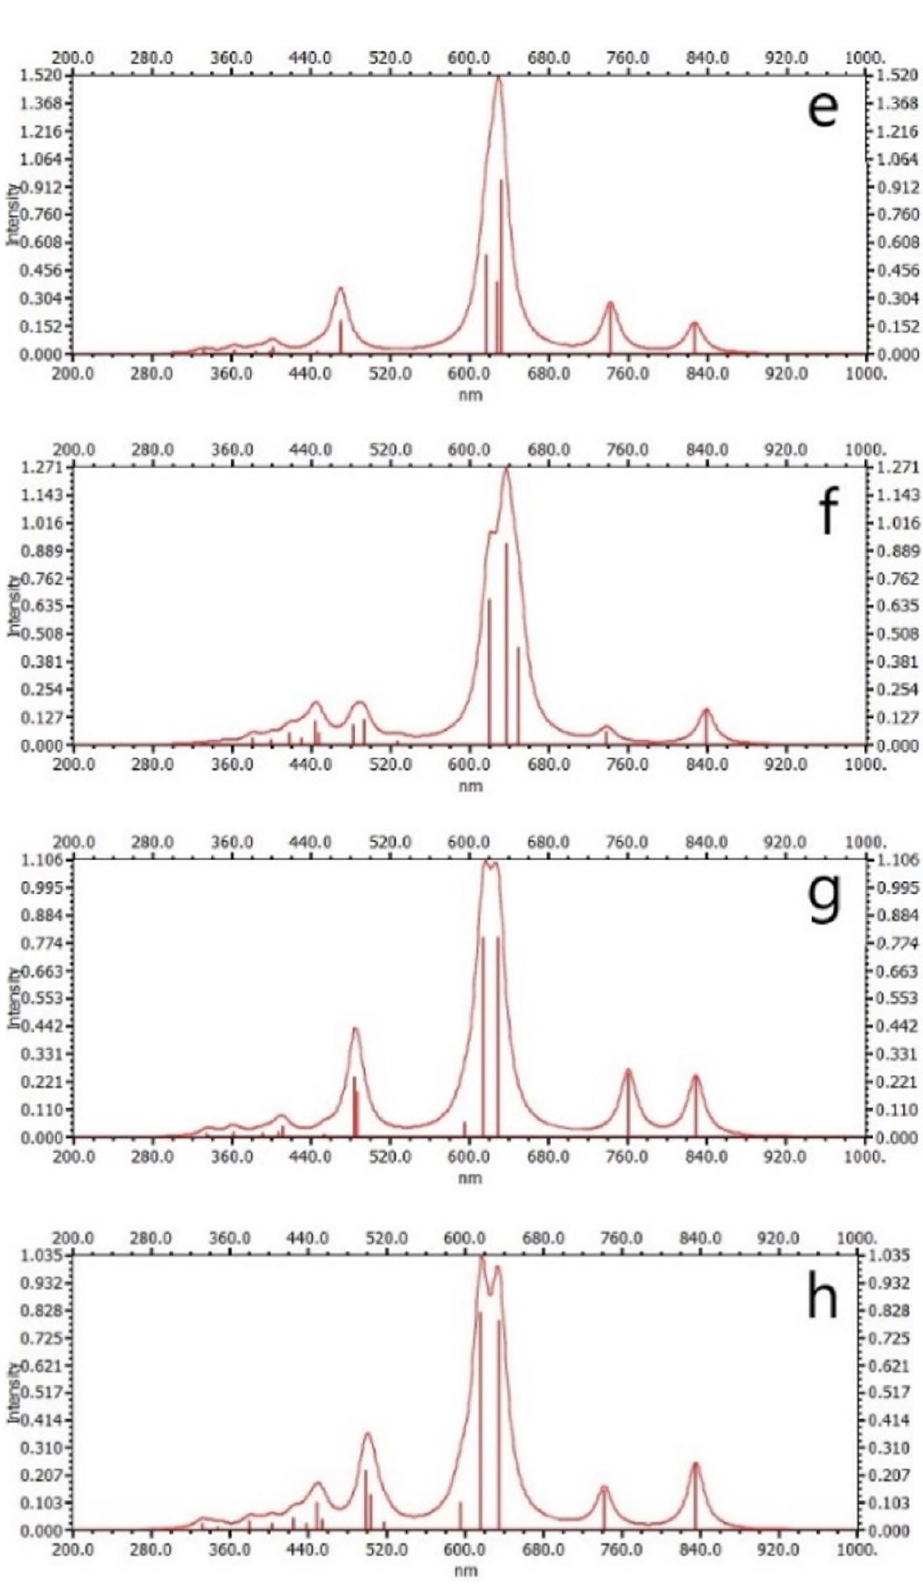
Figure 6. Electronic excitation spectra: ( a ) CePc 2 , ( b ) zigzag (9,0) boron nitride nanotubes decorated with CePc 2 complex, ( c ) EuPc 2 , ( d ) zigzag (9,0) boron nitride nanotubes decorated with EuPc 2 complex, ( e ) TbPc 2 , ( f ) zigzag (9,0) boron nitride nanotubes decorated with TbPc 2 complex, ( g ) YbPc 2 , and ( h ) zigzag (9,0) boron nitride nanotubes decorated with YbPc 2 complex.